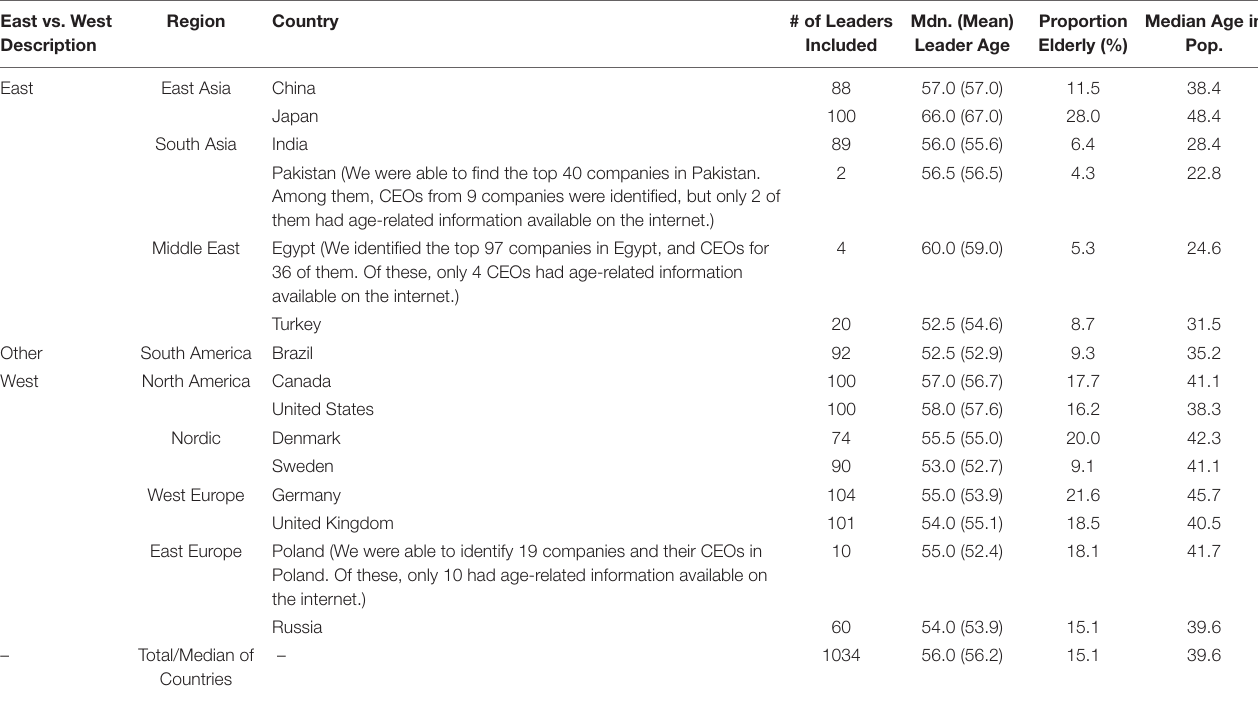
TABLE 1 | List of included countries with region and number/ages of leaders included (Study 1). East vs. West